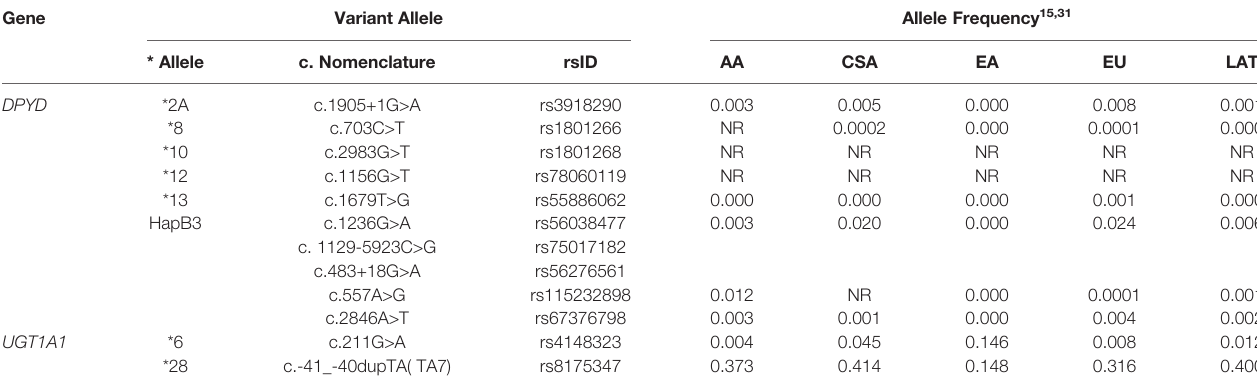
TABLE 1 | Description and prevalence of actionable DPYD and UGT1A1 pharmacogenetic variants tested in the IMPACT-GI